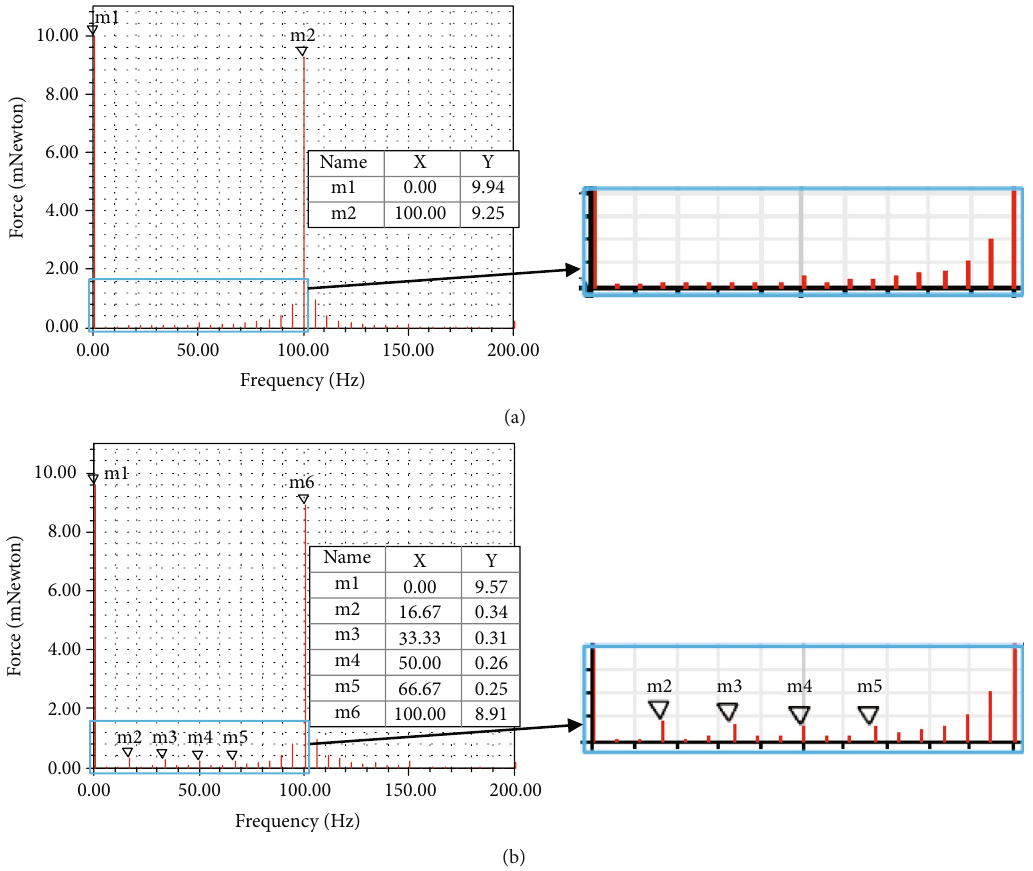
Figure 8: Electromagnetic force spectrum of the MJF-30-6 simulator: (a) in normal and (b) under